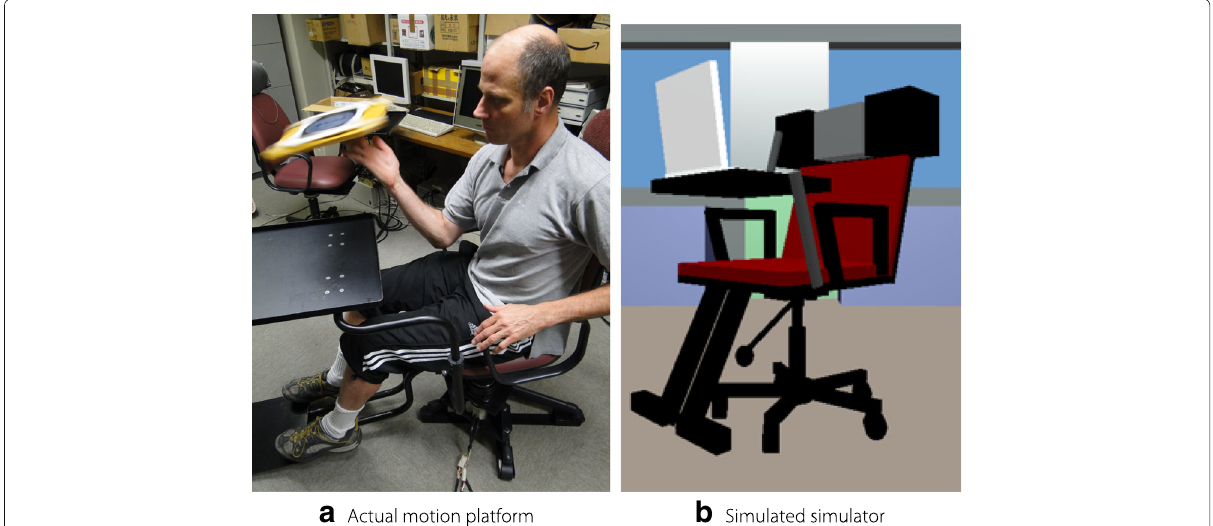
Fig. 11 The “ S c ha i r e ” rotary motion platform is a swivel chair. A servomotor in the base spins the chair under dynamic control. Nearphones in the headrest display panned, stabilizable